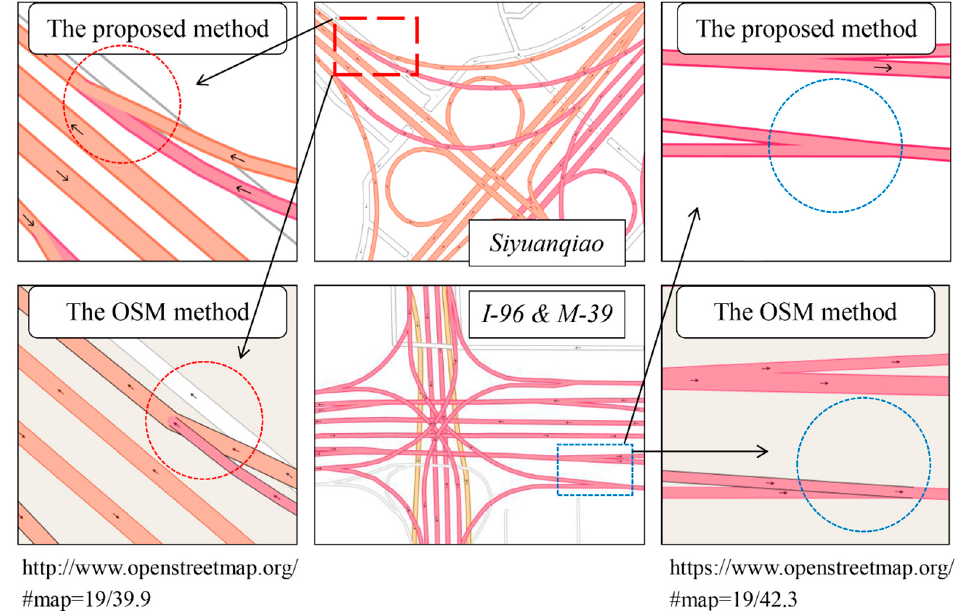
Figure 17. Rendering details compared with OSM.